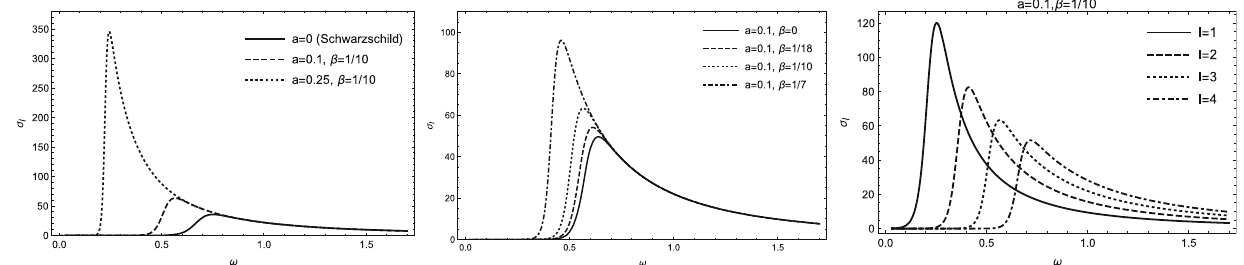
Fig. 3 For β > 0 and M = 1, the partial absorption cross section for the variable a at β = 1 l = 3 in the center panel. The right plot is that the partial absorption cross section changes with the multipole number l at a = 0 . 1 ,β = 1